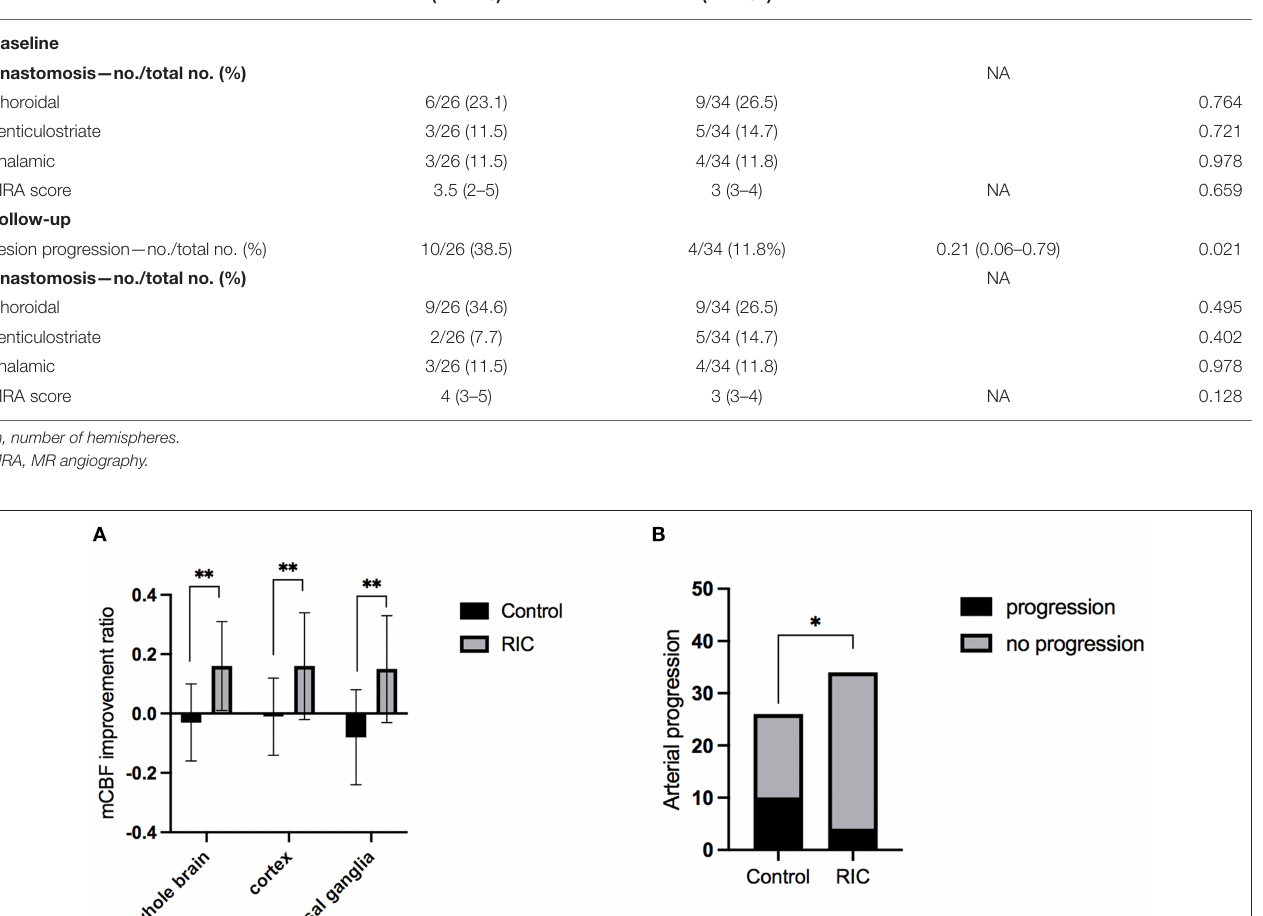
TABLE 3 | Features of periventricular anastomosis and arterial progression. Neuroradiologic outcome